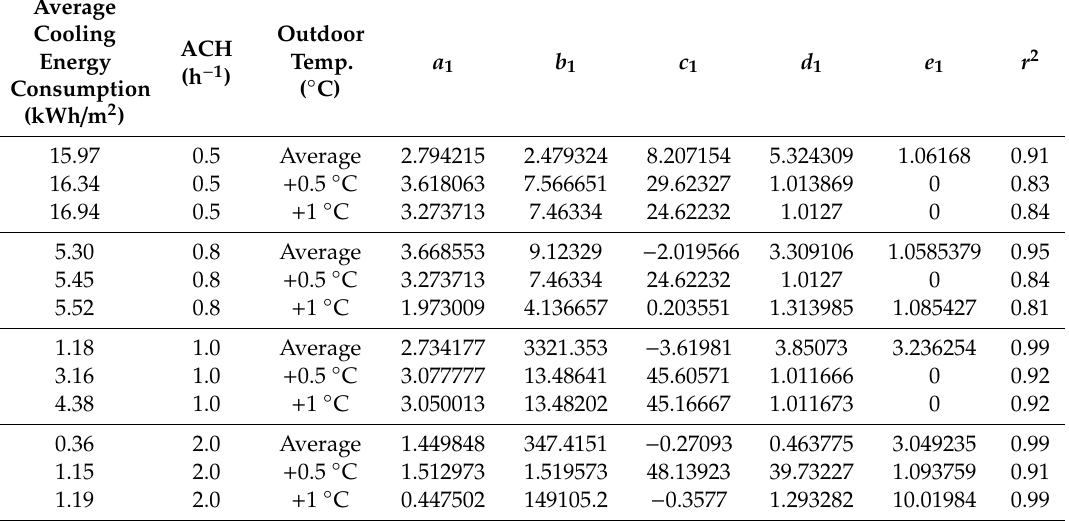
Table 2. Curve fitting of probability density function during the cooling